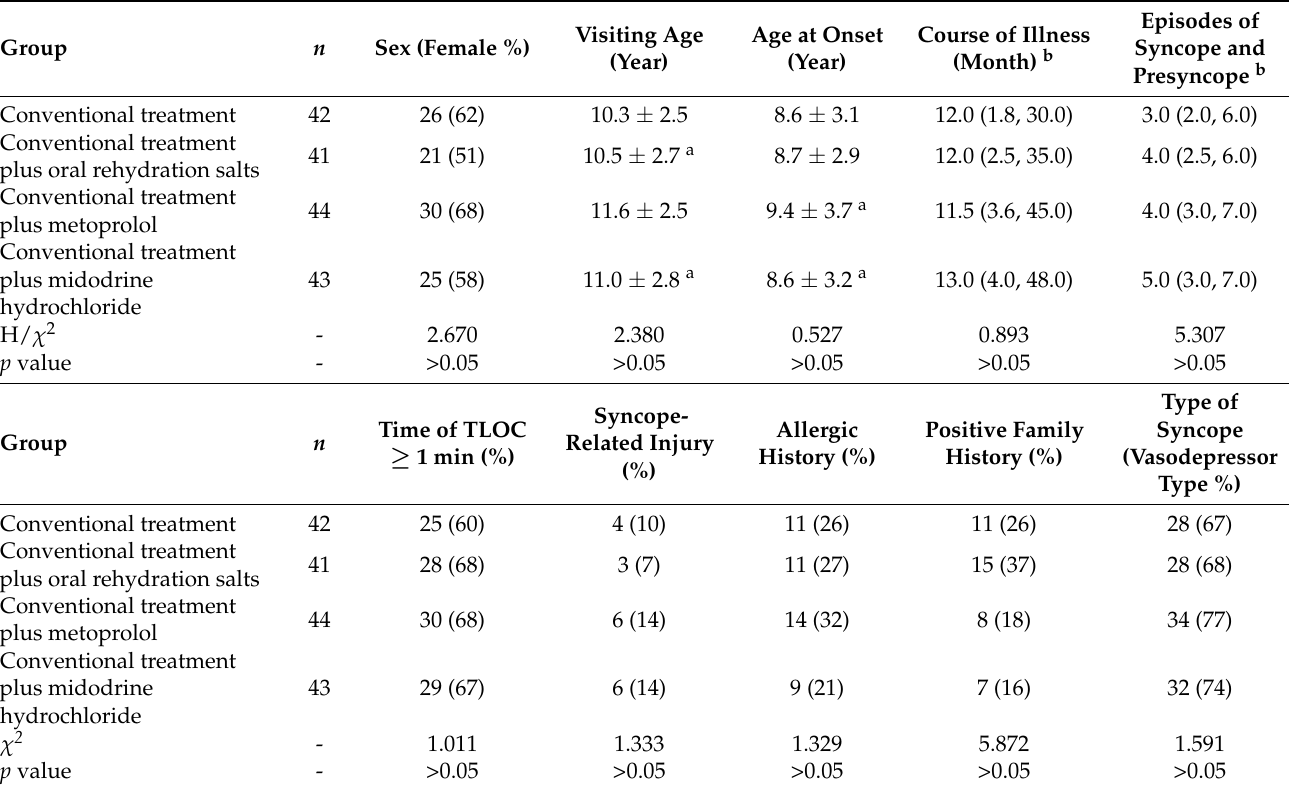
Table 2. Analysis of clinical characteristics among the different treatment